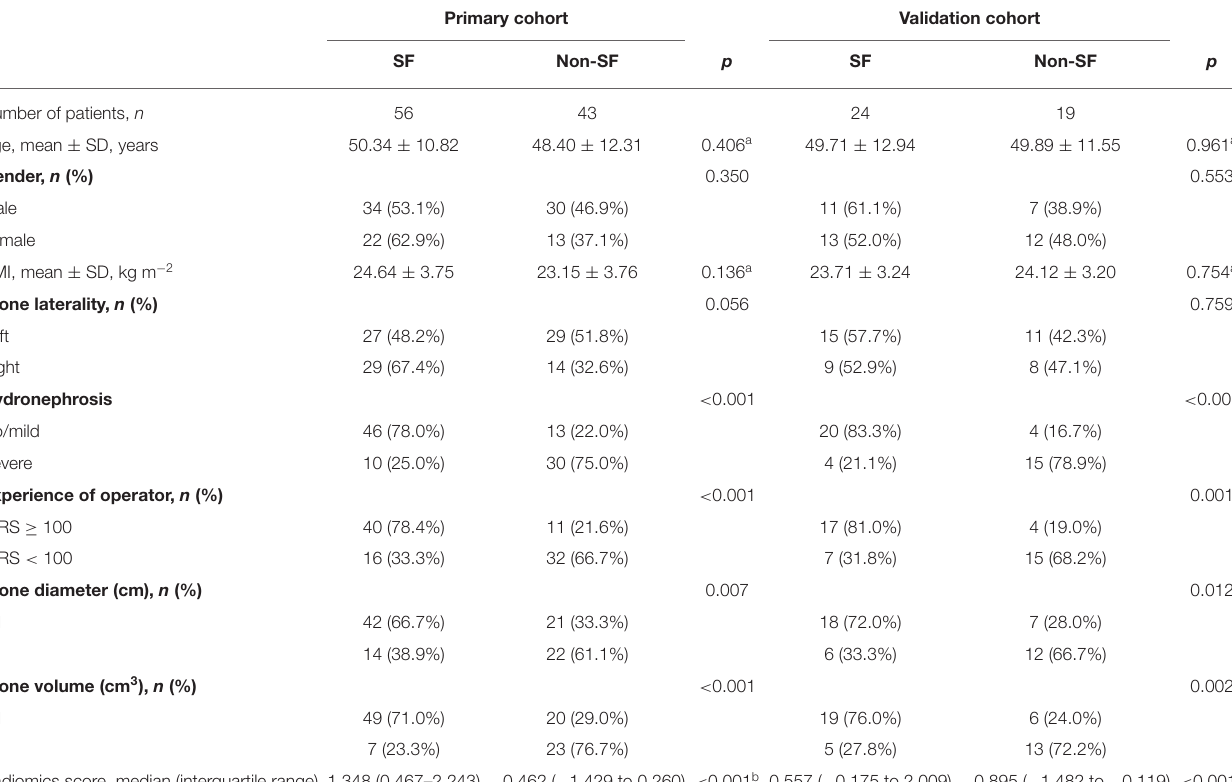
TABLE 3 | Characteristics of lower calyx stone patients in the primary and validation